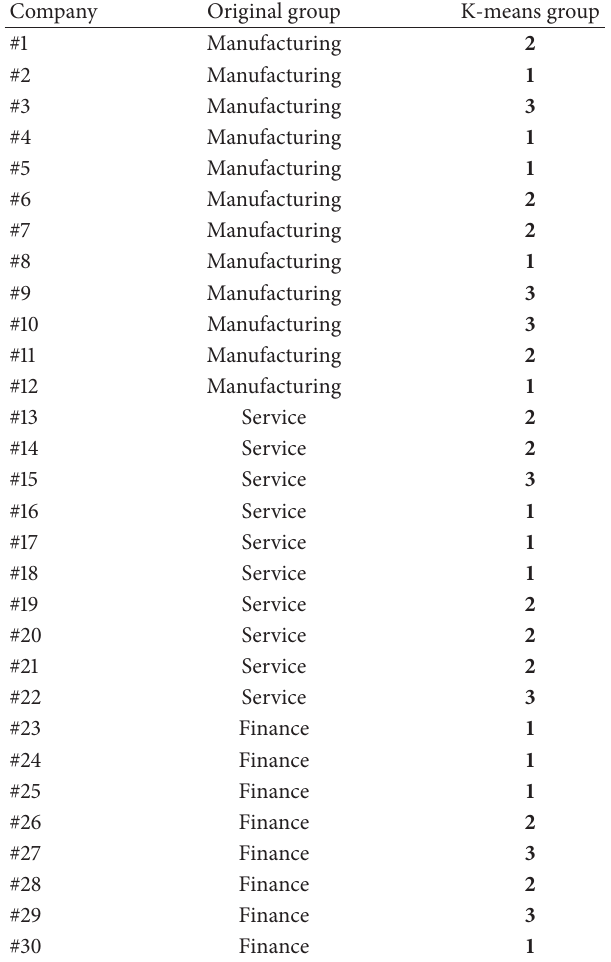
Table 2: Comparison of the K-means clustering results and the original grouping